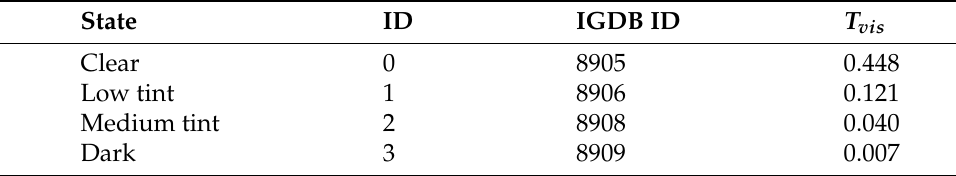
Table 3. Properties of various states of electrochromic glass and their